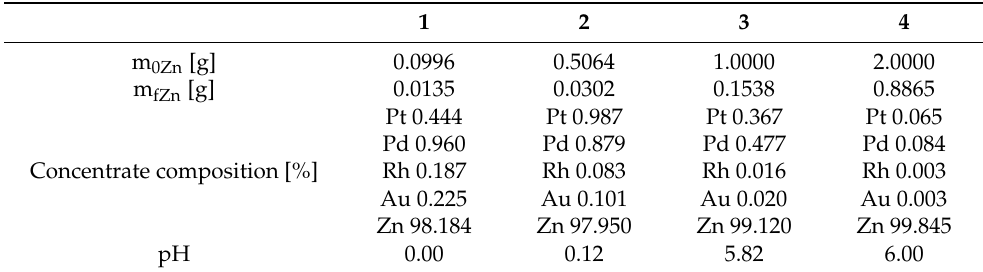
Table 7. Cementation experiment results with the use of zinc powder; m 0Zn —initial mass of zinc powder, m fZn —final mass of zinc powder.